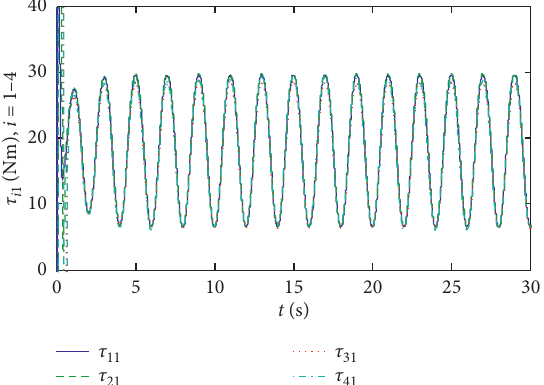
Figure 19: The control input torque τ